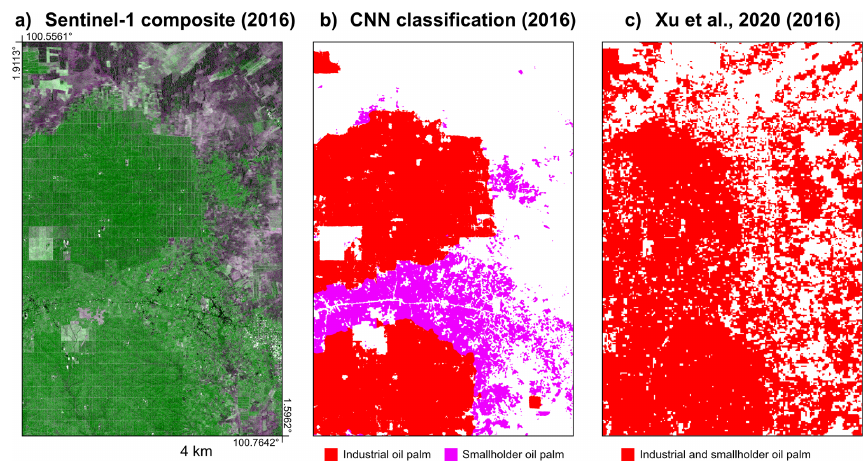
Figure 7. Comparison of the classification image obtained with the convolutional neural network (CNN) and the last year of the multiannual analysis presented in Xu et al. (2020). Panel (a) shows a Sentinel-1 composite (VV-VH-VV) for the second half of 2016 in Riau province (Indonesia). The VV and VH bands were transformed and stretched so that closed-canopy oil palm appears in green. Panel (b) shows the classification image that results from the CNN using the Sentinel-1 and Sentinel-2 composites for 2016. Panel (c) shows the oil palm layer presented in Xu et al. (2020) for the year 2016 (image source: Copernicus Sentinel data